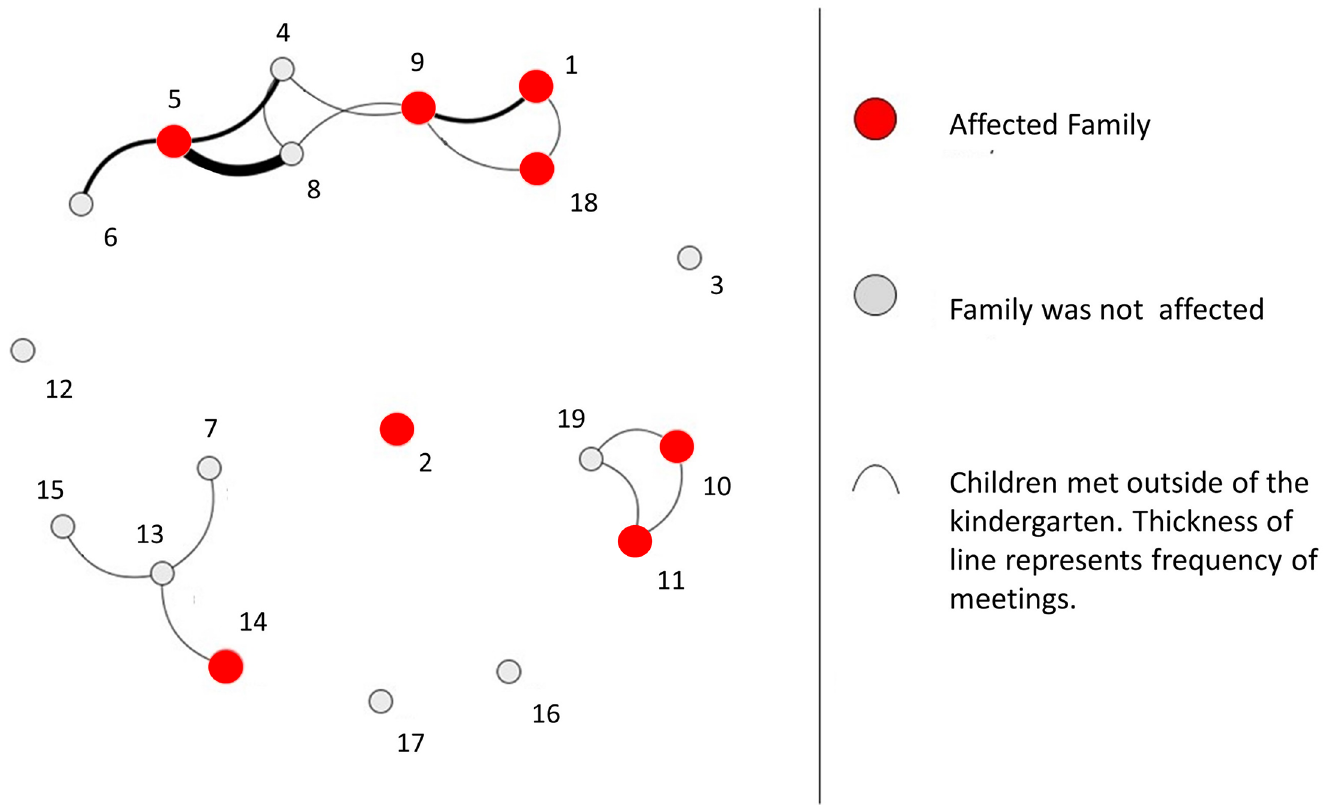
Fig 1. Visualization of the social network among kindergarten families outside of the